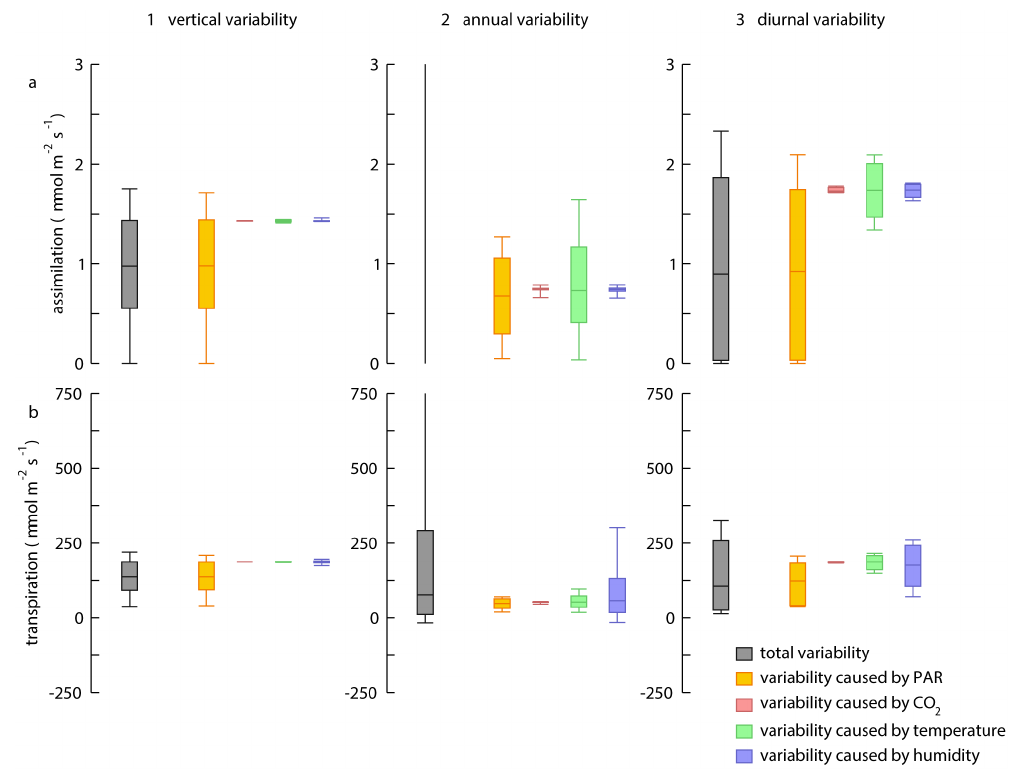
Figure 10. Explanation of variability of simulated (a) CO 2 assimilation and (b) transpiration for (1) vertical variability ( n = 25), (2) annual variability ( n = 277) and (3) diurnal variability ( n = 48). Shown are the distributions (box indicates the median and the 25–75% percentile, whiskers indicate full distribution) obtained from the full simulation, and from simulations that exhibit variability only for one parameter (see text for